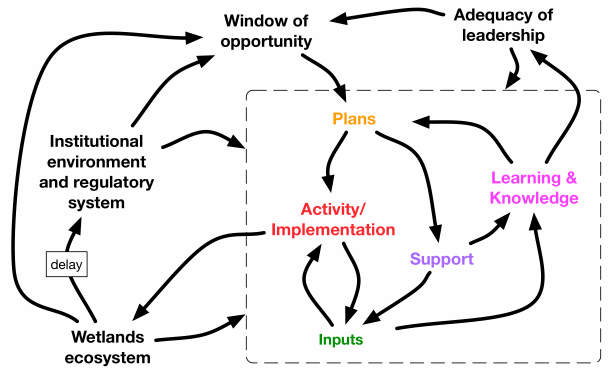
Fig. 4 . An overview level causal loop diagram (CLD), synthesizing the core dynamics of studied wetland restoration initiatives in Belarus. Three sets of drivers triggered windows of opportunity and subsequently influenced five core management processes (in dashed box). Arrows connecting directly to dashed box indicate the influence of a given driver on multiple processes within the box. Figures 5–9 unpack the dynamics of each of the core processes and relationships with